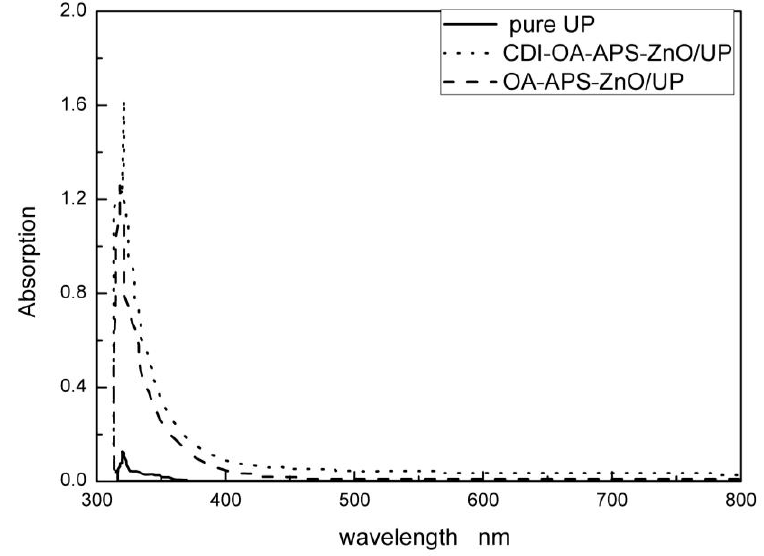
Figure 11. UV–Vis absorbance of ZnO/UP composites.